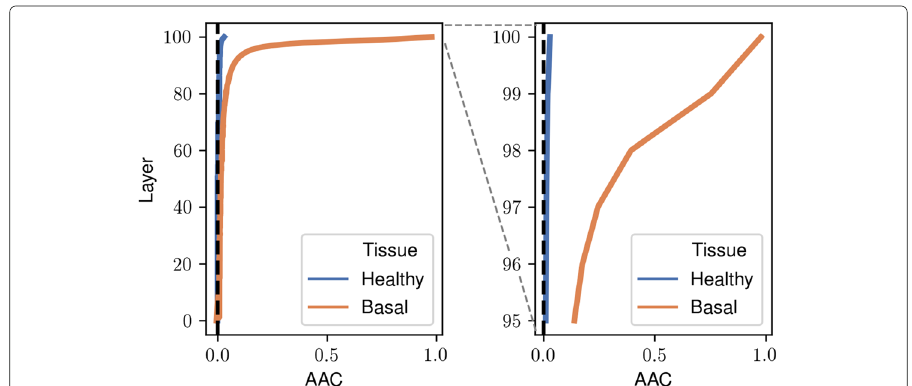
Fig. 2 Inter/intra-chromosomal connectivity as measured by the attribute assortativity coefficient (AAC, where a value close to 1 imply weak inter-chromosomal connectivity and values close to 0 imply random-like inter-chromosomal connectivity) of healthy and breast cancer (Basal subtype) gene co-expression networks. Left plot shows all 101 co-expression layers while right plot zooms-in on the top 6 layers